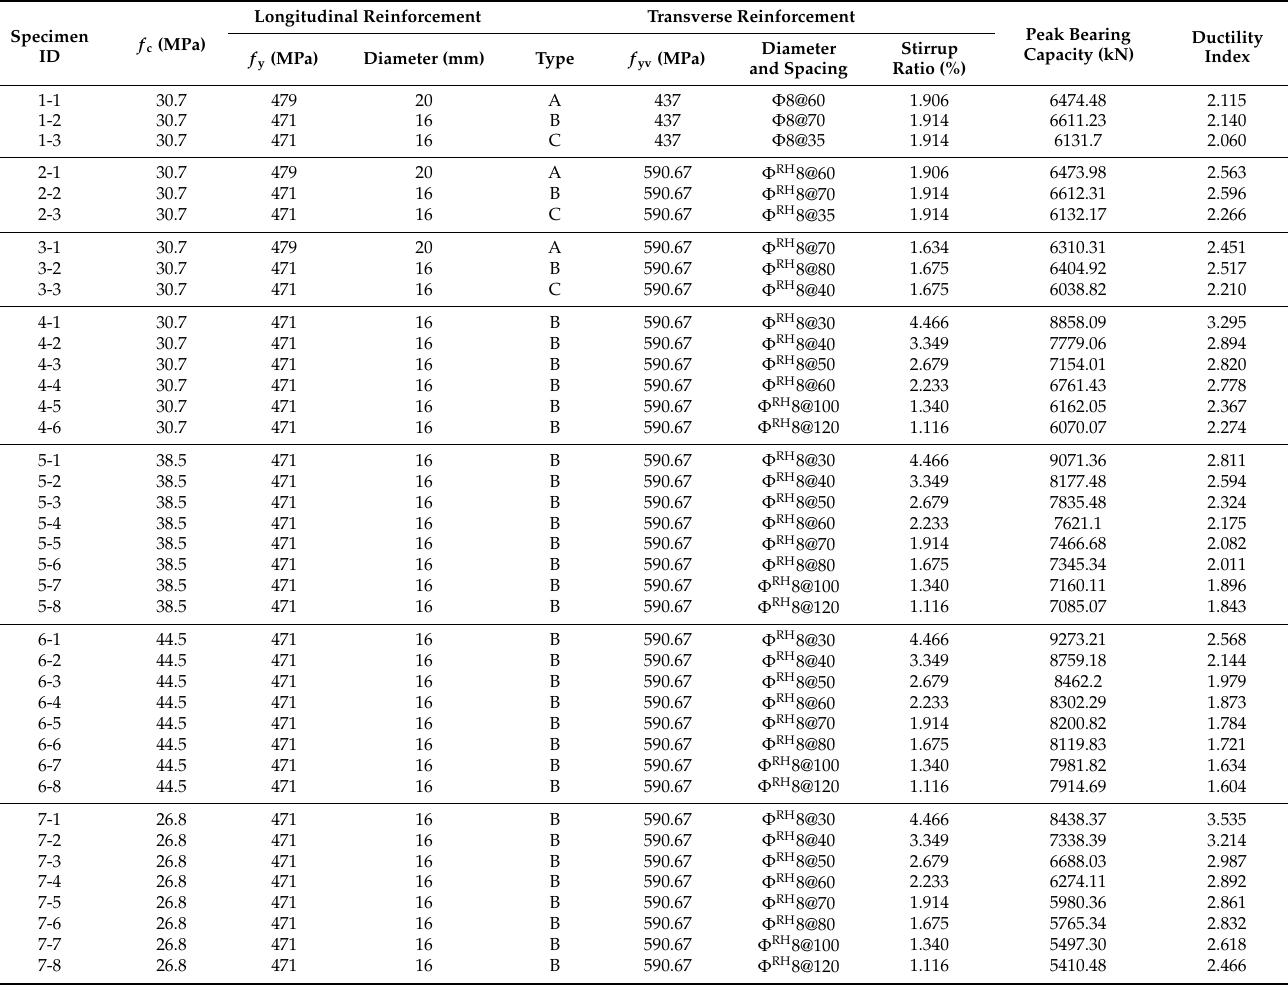
Table 3. Specimen design